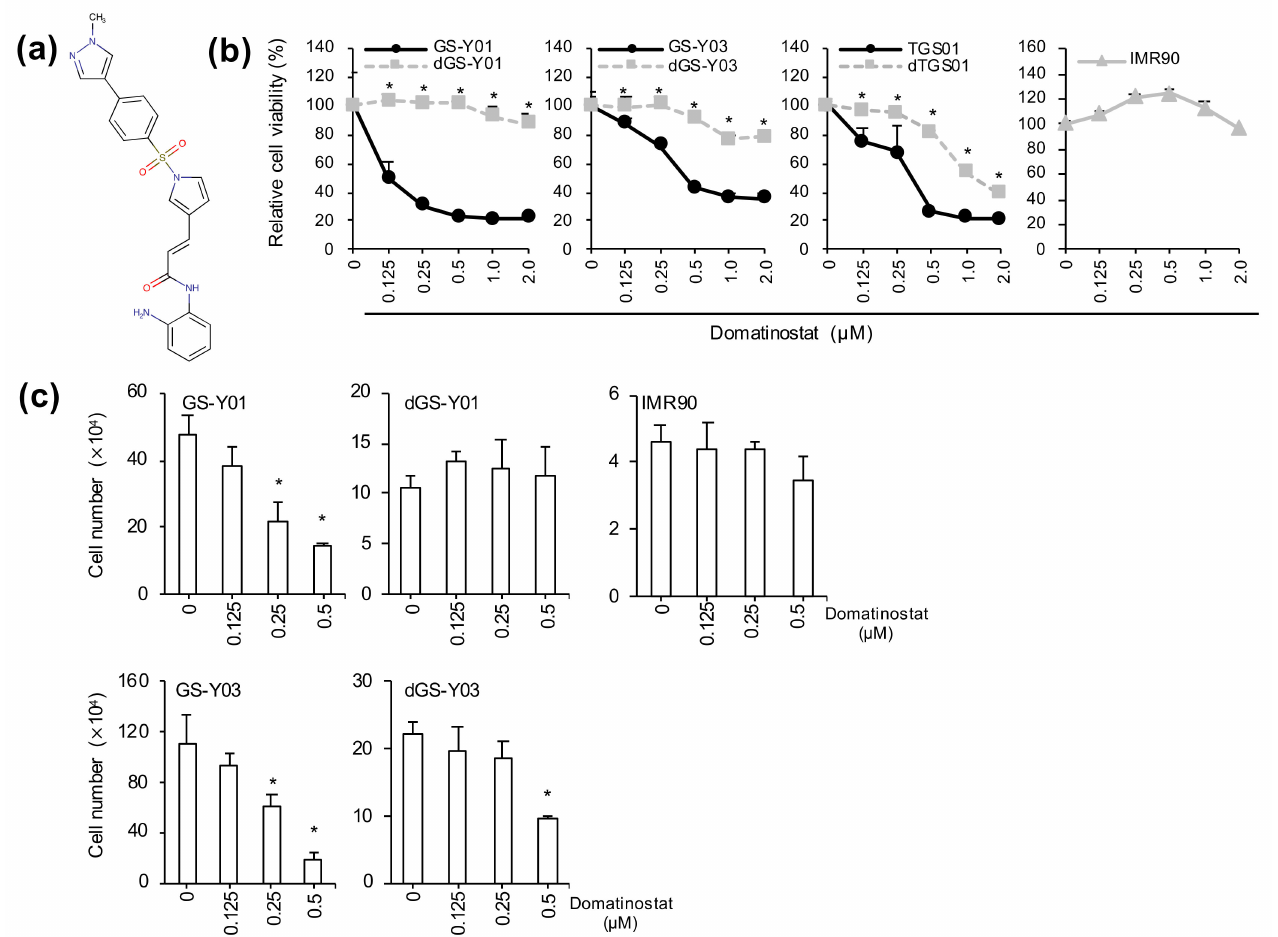
Figure 1. Effect of domatinostat on the growth of glioma stem cell lines, their differentiated coun- terparts, and normal fibroblasts. Values are presented as the means + SD of the triplicate samples. Similar results were obtained from two independent biological replicates. ( a ) The chemical struc- ture of domatinostat (4SC-202). ( b ) Determination of metabolic viability. GS-Y01, GS-Y03, TGS01, their differentiated counterparts (dGS-Y01, dGS-Y03, dTGS01), and IMR90 human lung fibroblasts treated with the indicated concentrations of domatinostat for 3 days were subjected to the WST assay. * p < 0.05 vs. undifferentiated glioma stem cells treated at the same concentration by the Student’s t -test. ( c ) Viable cell count determined by dye exclusion. GS-Y01, GS-Y03, their differen- tiated counterparts (dGS-Y01, dGS-Y03), and IMR90 human lung fibroblasts were treated with the indicated concentrations of domatinostat for 3 days, and the number of viable cells was determined by trypan blue dye exclusion. * p < 0.05 vs. cells treated without domatinostat (i.e., at 0 µ M) by the Student’s t